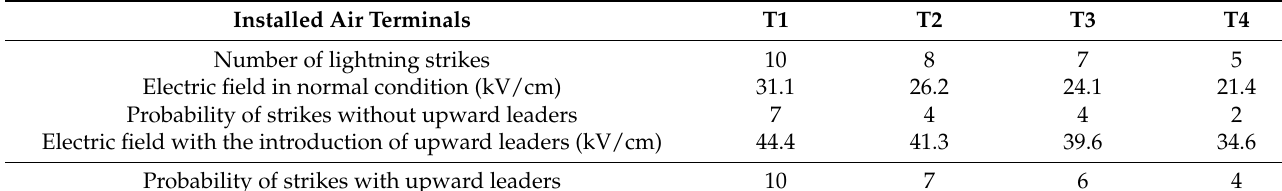
Table 6. Probability of lightning strikes on a square-shape building.